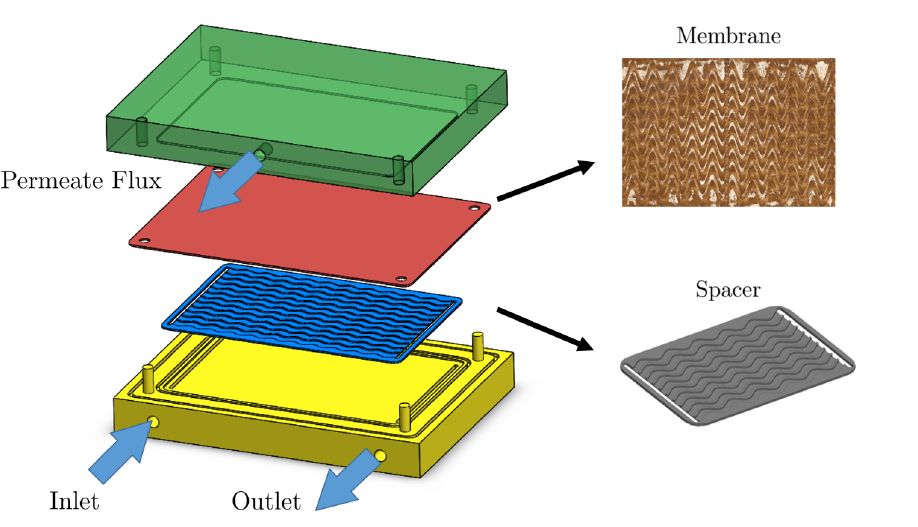
Figure 2. Three-dimensional rendering of the experimental setup by Xie et al. [24]. The membrane after flooding experiment together with a detailed rendering of spacer structure are shown on the right-hand side.